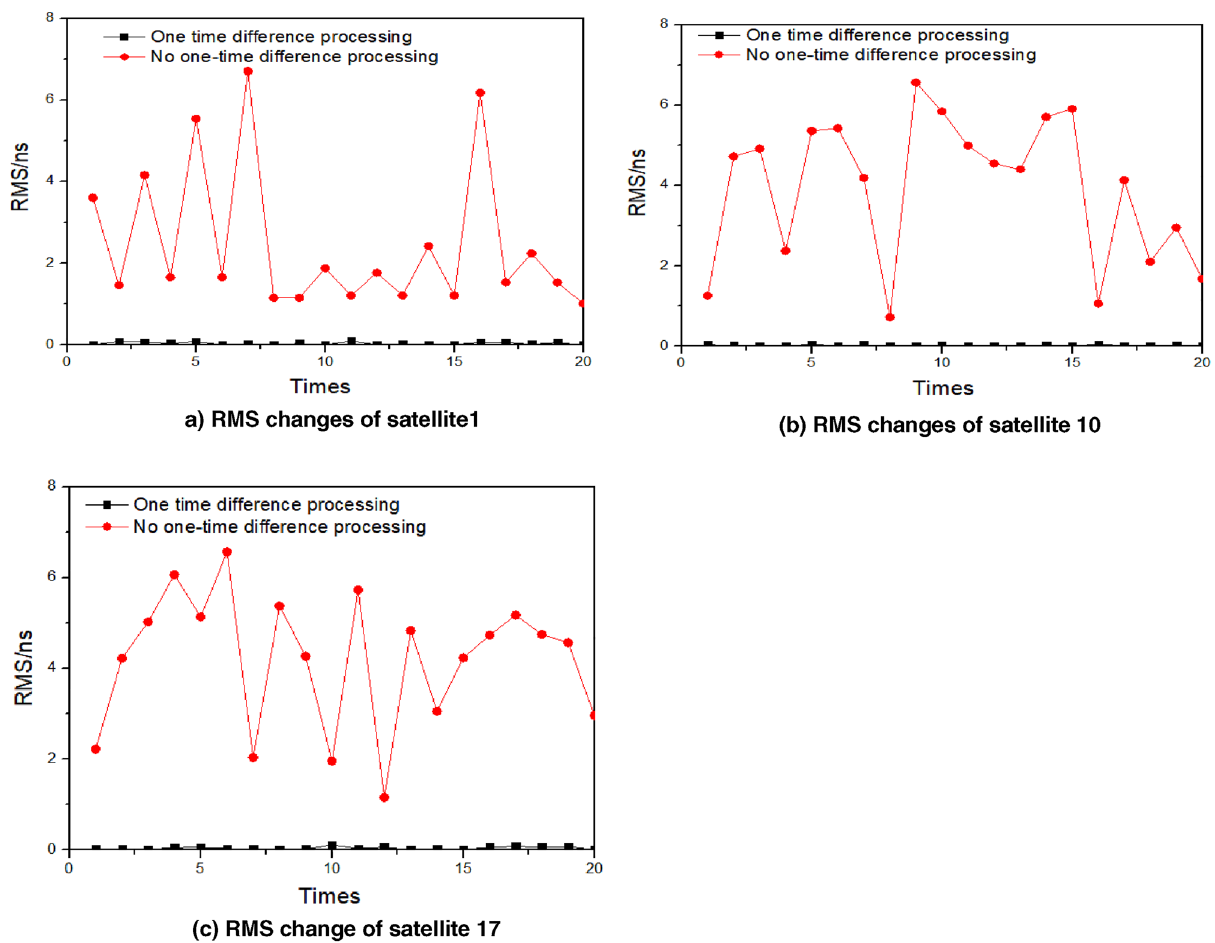
Figure 5. The variation in RMS using BP to predict clock bias before and after one difference about 20